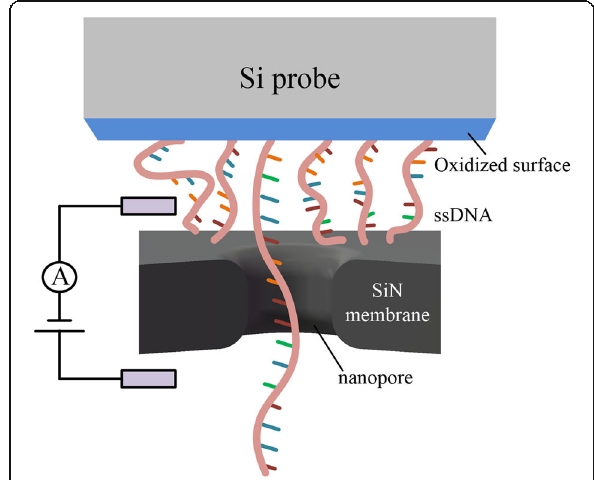
Fig. 5 Schematic of the DNA-immobilized Si probe system used for nanopore DNA detection [32]